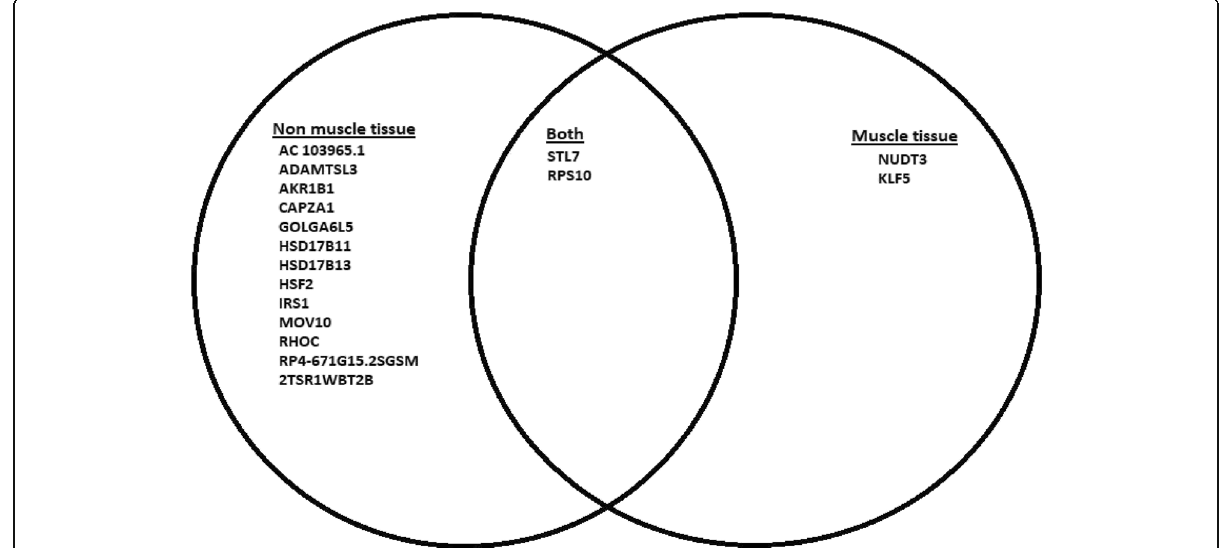
Fig. 1 Gene expression based on SMR of GTEx eQTLs and whole-body lean mass